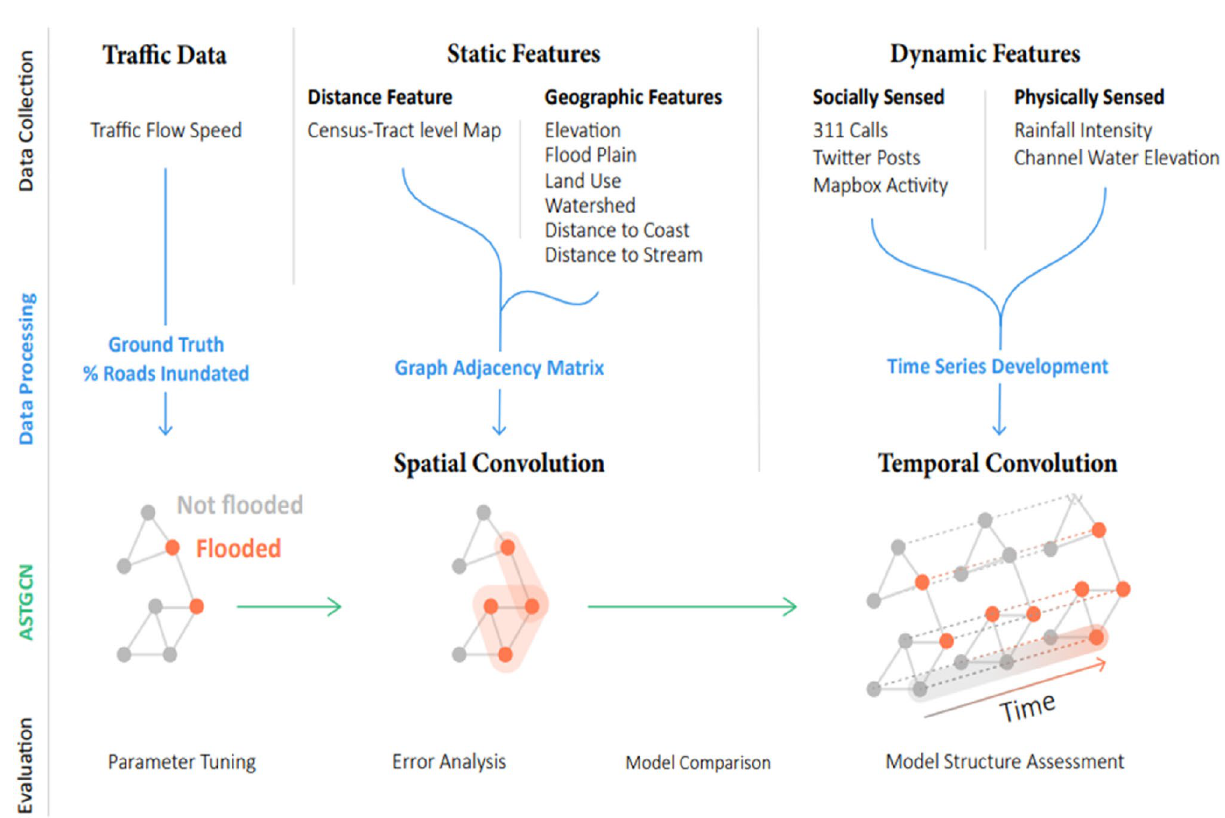
Figure 2. Overview of the model framework, including steps for collecting and preprocessing ground truth and features, developing the ASTGCN model architecture, and evaluating the performance of the